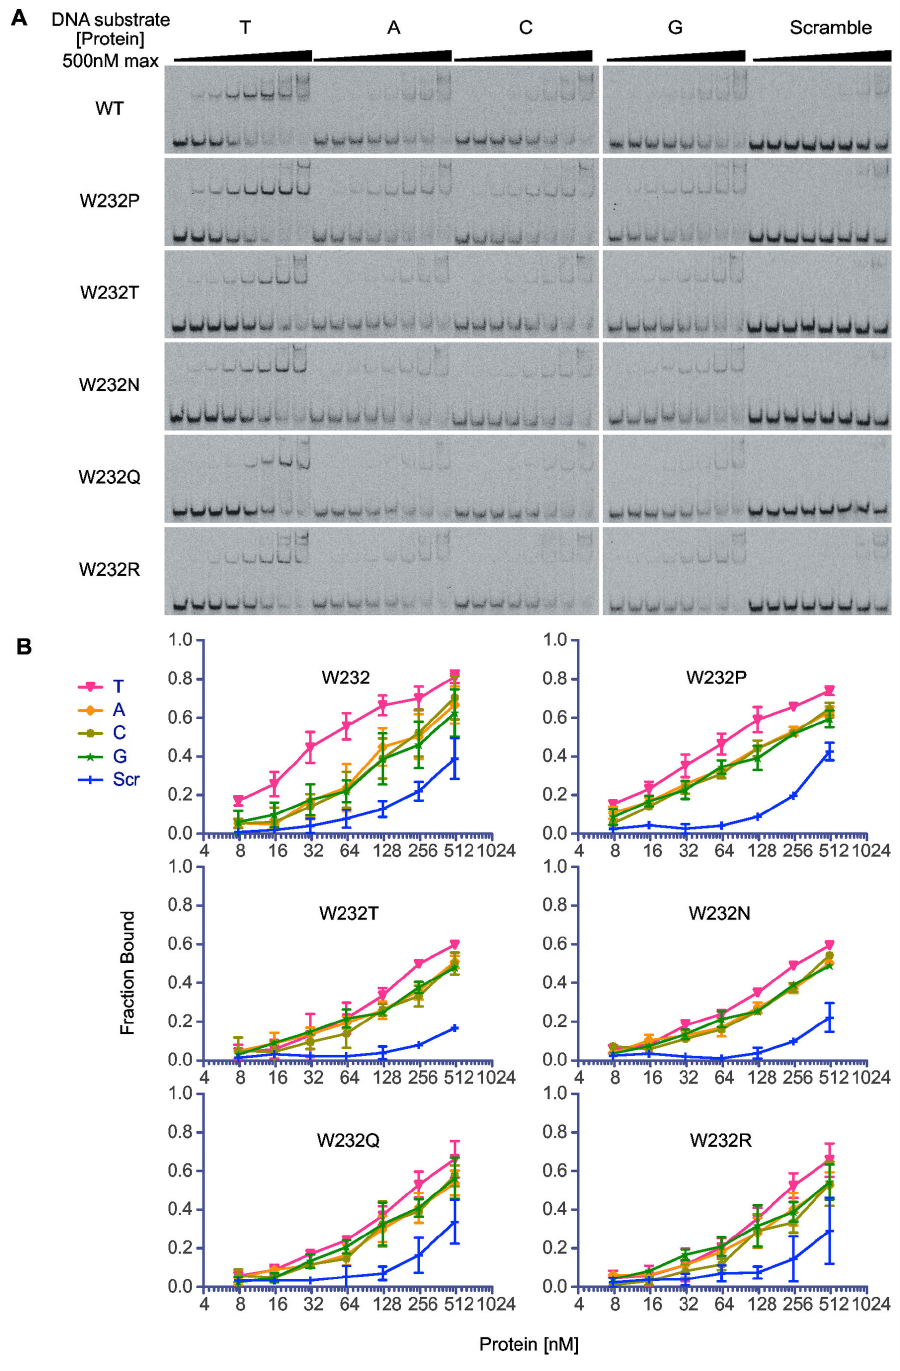
Figure 4. Relative binding affinities of TAL868 and selected W232 substitution variants for the TAL868 target DNA with T, A, C, or G at the 0 th position. A. Electrophoretic mobility shift assay of labeled TAL868 target DNA with T, A, C, or G in the 0 th position, or a scrambled target, (as labeled at top) following incubation with increasing amounts (left to right) of TAL868 (W232) or selected W232 substitution variants, as labeled. Bands across the bottom represent unbound DNA. The next bands up represent DNA bound by the TAL effector. The uppermost bands represent higher order complexes. DNA bound at lower protein concentrations indicates higher affinity. Each interaction was assayed at least twice. Representative gel images are shown. B. Results from all experiments, reported as the fraction of DNA bound by the protein, estimated by band densitometric analysis. Error bars represent standard deviation. doi: 10.1371/journal.pone.0082120.g004 PLOS ONE |